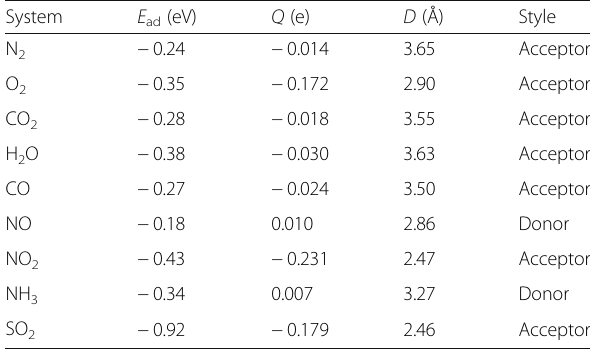
Table 1 Adsorption energy ( E ad ), Mulliken charge ( Q ) from the molecule to monolayer BAs, and distance (gas molecule/BAs) of the equilibrium nearest atom of gas molecule to atom of BAs